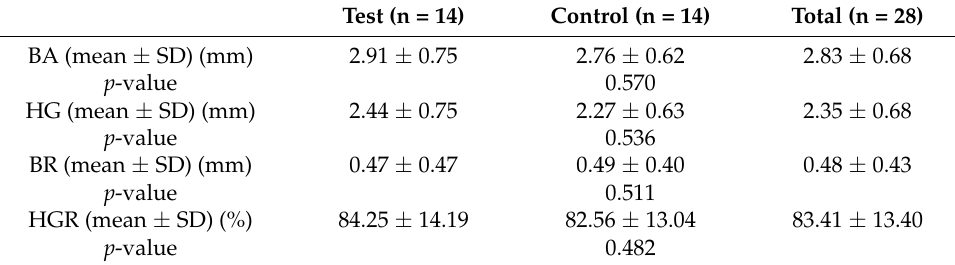
Table 3. Radiological assessment of BA, HG, and HGR between the groups.